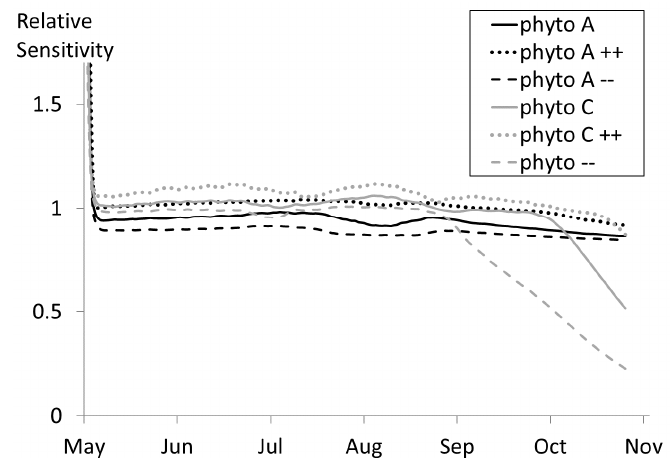
Figure 8. Results of the global sensitivity analysis when increasing ( ++ ) or decreasing ( −− ) the initial biomass concentration of diatoms (legend: phyto A: chrysophytes, cryptophytes; phyto C: chlorophytes, dinoflagellates and cyanophytes).